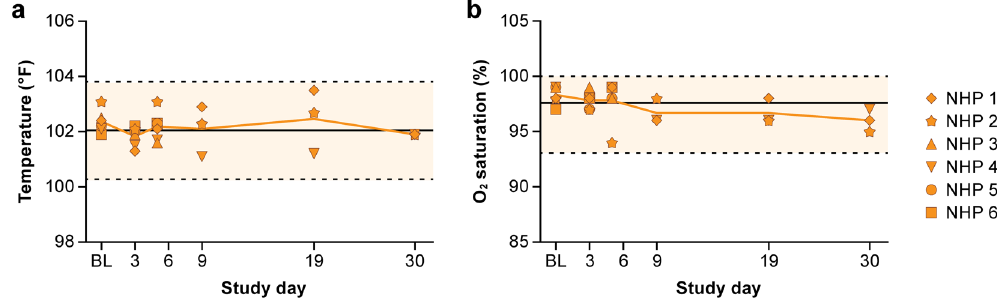
Figure 1. Temperature and arterial O2 saturation. ( a ) Study animals did not develop fever or deviate outside of normal macaque temperature ranges. ( b ) Animals did not exhibit O 2 saturation loss outside of normal macaque ranges. Normal ranges are depicted in beige.